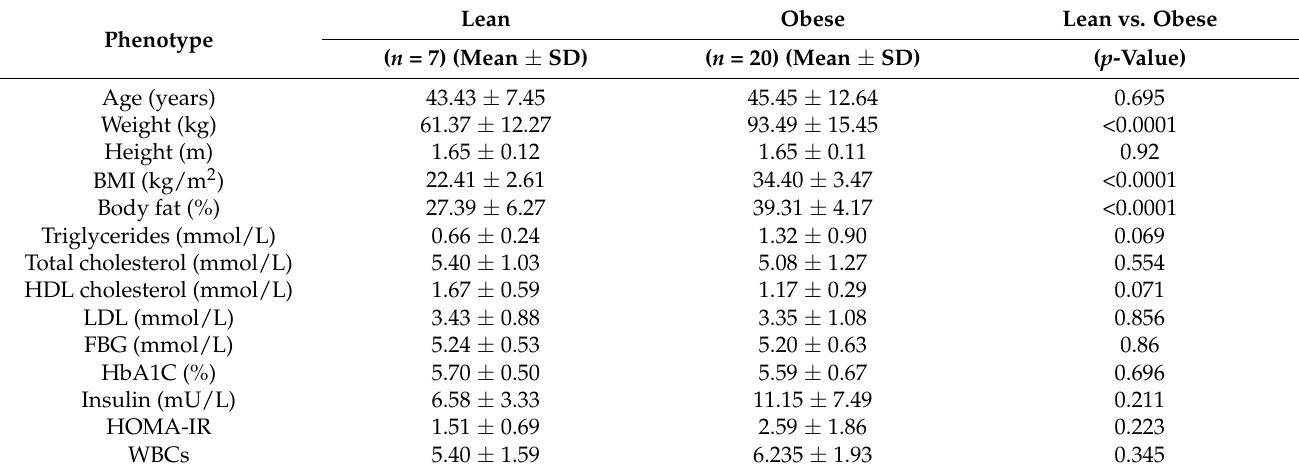
Table 1. Anthropometric measurements and clinical characteristics of the study